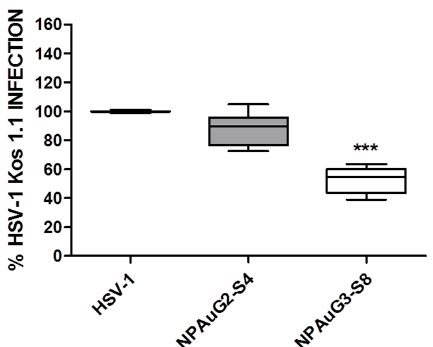
Figure 5. Activity against HSV-1. NPAus were incubated with MOI 1 of HSV-1 at 4 °C. After 1 h, Vero cells were infected with HSV-1-NP mix, and the infection was revealed by plaque assay as performed before. Data represent median and interquartile range ± SD from four independent experiments performed by duplicate. ***: p < 0.001; **: p < 0.01; *: p < 0.05. HSV-1 infection control at MOI 1.